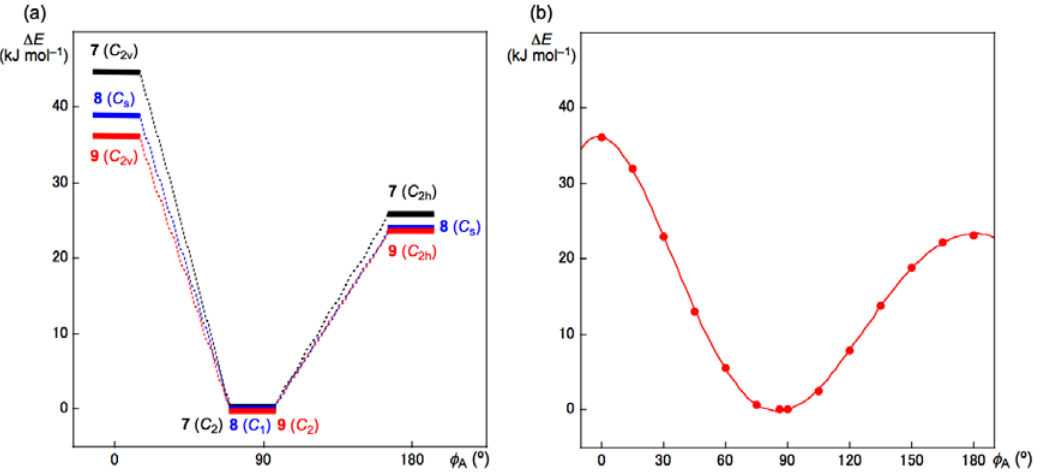
Figure 2. Plots of deformation energy ( ∆ E ) versus φ A . For 7 – 9 ( a ) and for 9 ( b ).